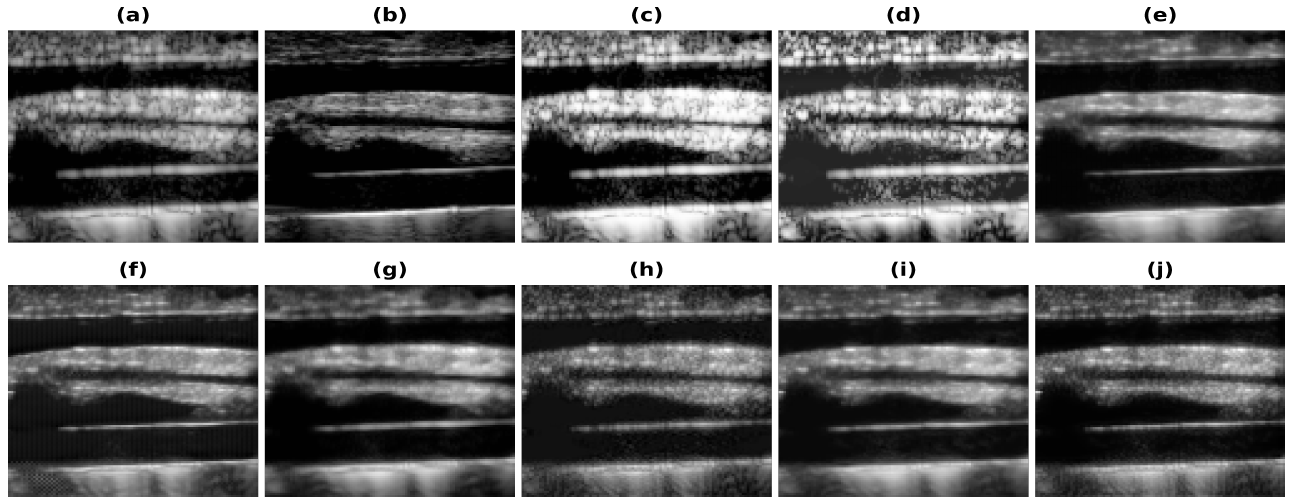
Figure 5. Results of the bandwidth improvement for Carotid artery phantom for different models ( a ) Band-limited image ( b ) Full Bandwidth image ( c ) Histogram Equalization ( d ) Contrast Limited Adaptive Histogram Equalization ( e ) U-Net-PL1 ( f ) U-Net-PL2 ( g ) SRCNN-PL1 ( h ) SRCNN-PL2 ( i ) REDNet-PL1 ( j ) REDNet-PL2.